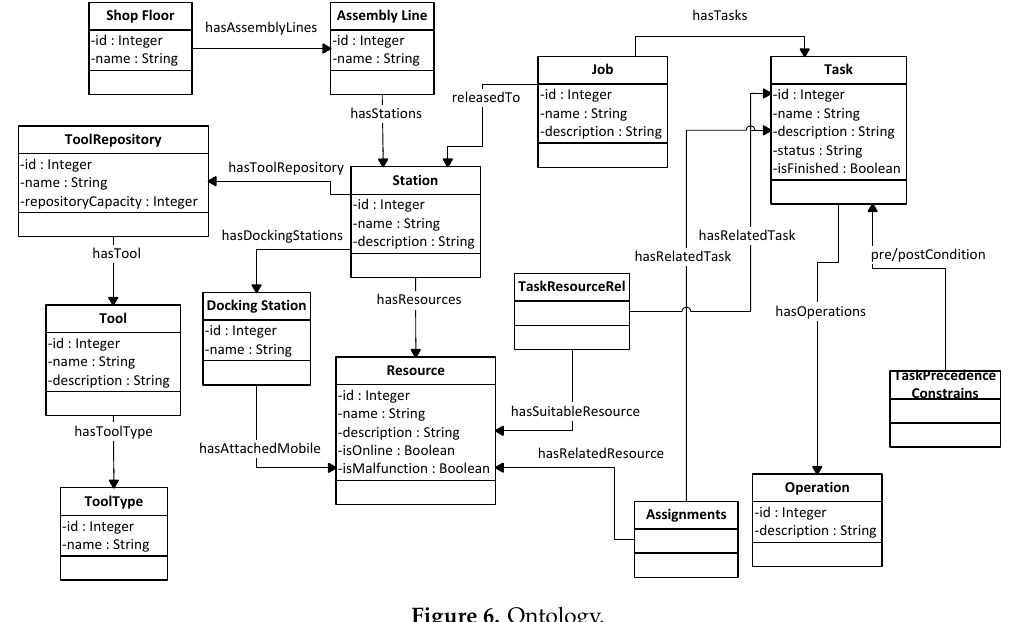
Figure 6. Ontology. Figure 6.